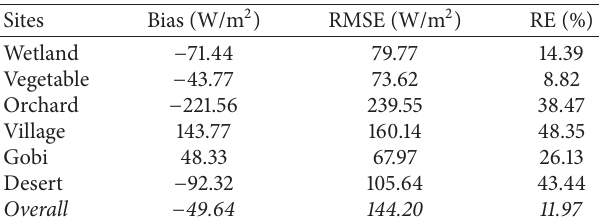
Table 5: Errors of RSLE at 6 sites; statistics include the bias, RMSE, and